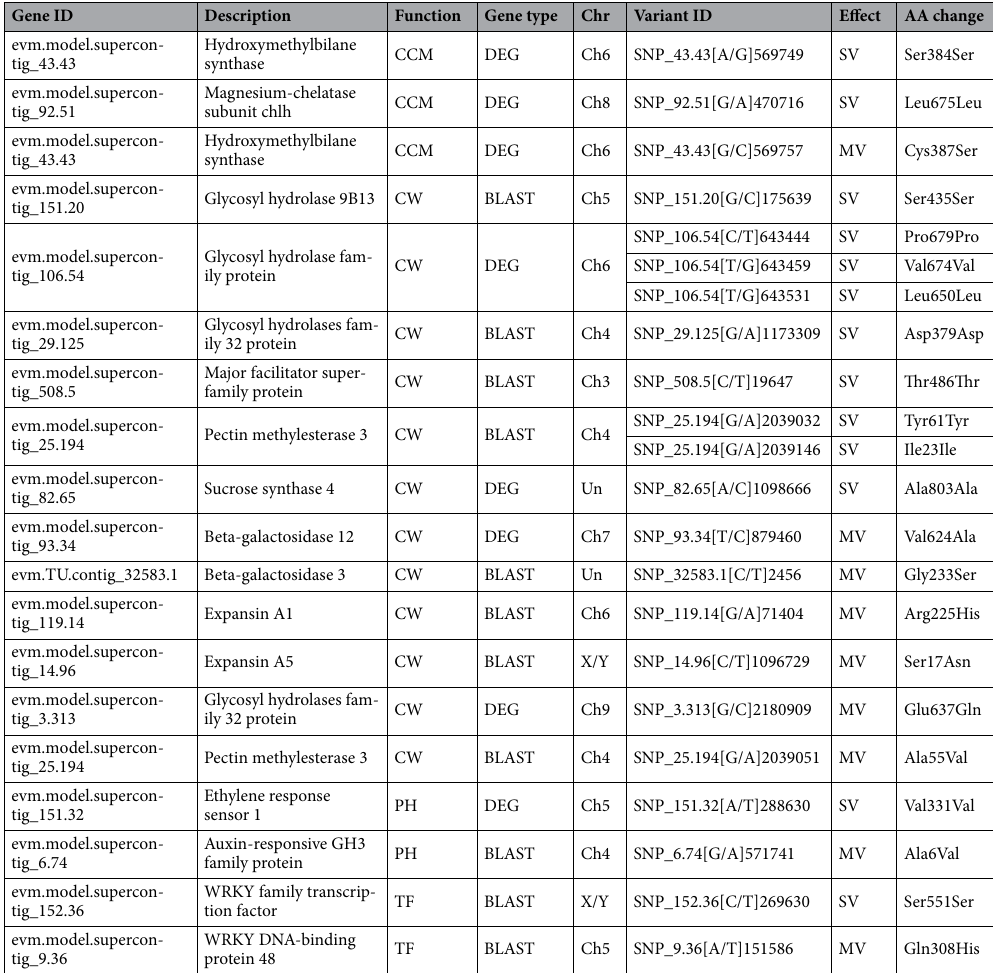
Table 2. Fruit ripening-related genes with low and moderate SNP impacts. AA amino acid, MV missense variant, SV synonymous variant, CW cell wall-related genes, CCM chlorophyll and carotenoid metabolism- related genes, PH plant hormone signal transduction pathway genes, TF transcription